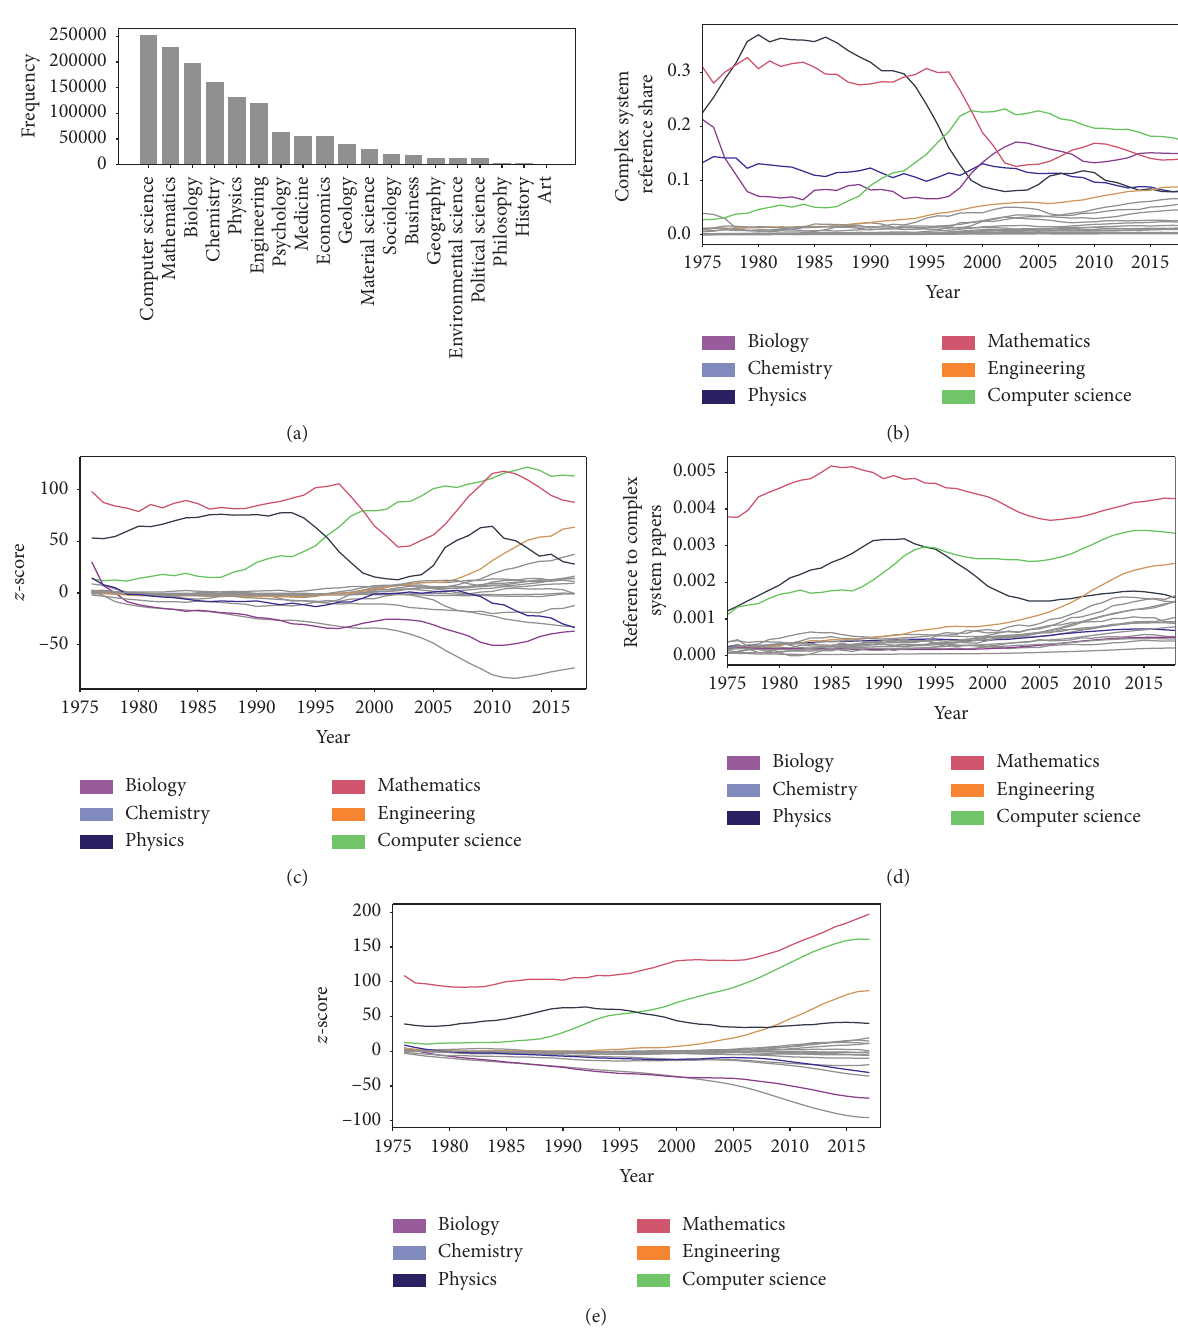
Figure 2: Knowledge between complex system study and other academic fields. (a) The distribution of academic fields for papers that cite or are cited by complex system research at least once. (b, c) The reference share and z -score (compared to the null model) from complex system research to other academic fields. (d, e) The same as (b) and (c) but from other academic fields to complex system